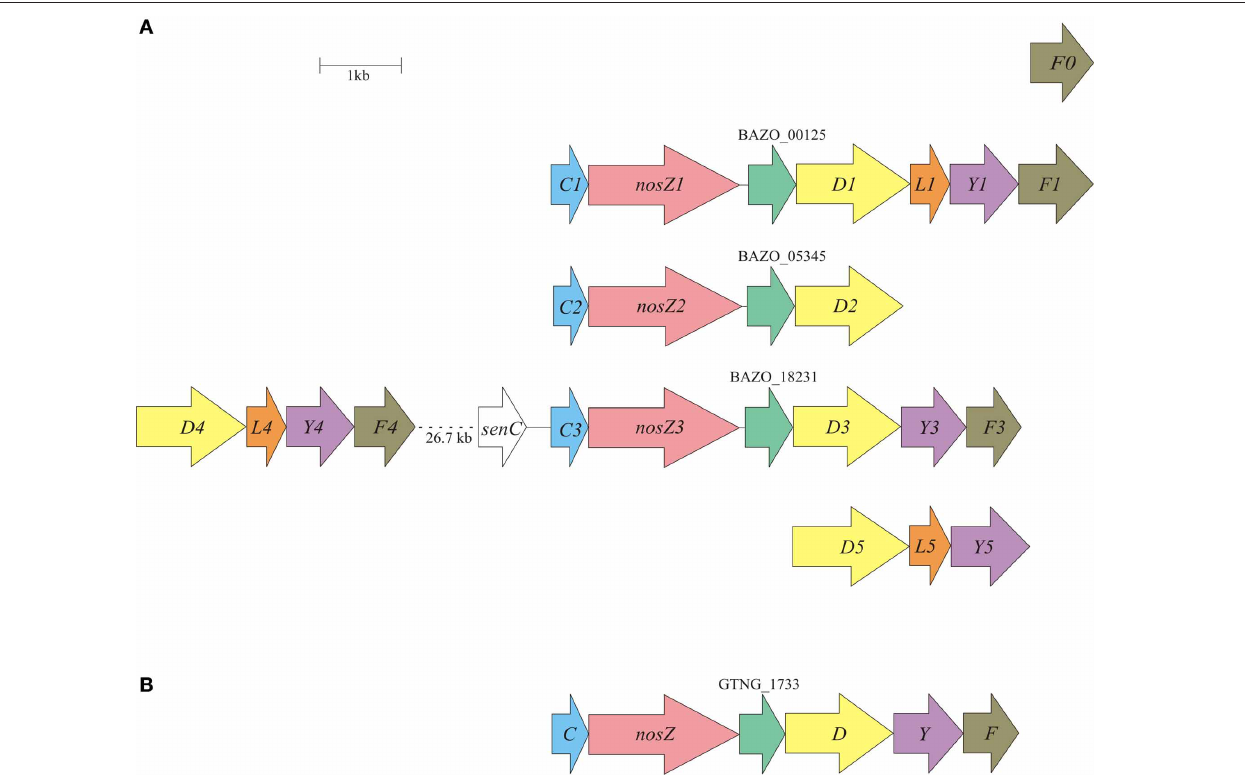
FIGURE 3 | Physical map of the B. azotoformans LMG 9581 T (A) and Geobacillus thermodenitrificans NG80-2 (B) nos gene clusters. Arrows show the direction of transcription. Open reading frames are drawn to scale. Homologous genes are shown in identical colors.